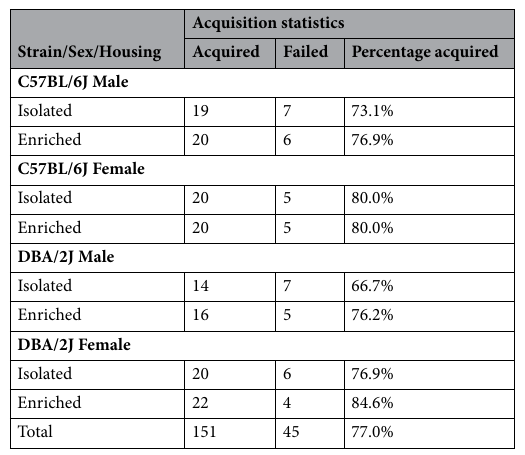
Table 1. The number of mice in each experimental group that acquired or failed to acquire the OSS response. Mice met acquisition criteria if they performed ≥ 10 active lever presses with ≥ 70% of responses on the active lever for three consecutive sessions during the FR-1 stage. FR-1, progressive ratio, and extinction responding of mice that met acquisition criteria is shown in Figs. 1 –